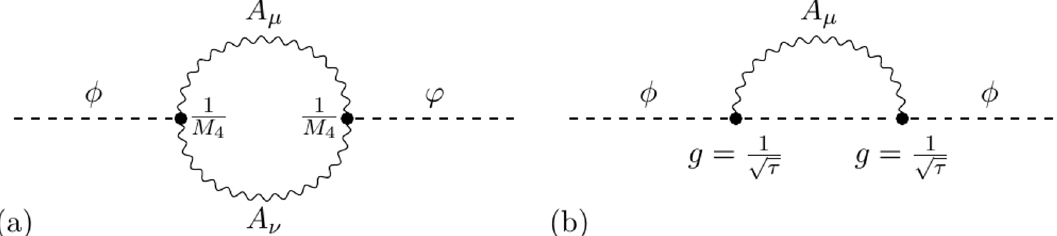
Figure 3 . (a) 1-loop diagram for a D7-brane gauge field correcting the kinetic term of a modulus. (b) 1-loop diagram for the wave function renormalization of a charged scalar induced by the gauge